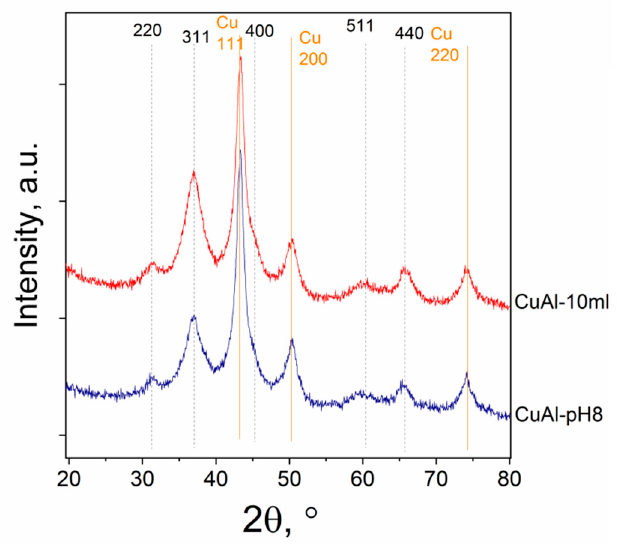
Figure 6. XRD measurements of the CuAl-pH8 and CuAl-10mL samples reduced at 120 °C.